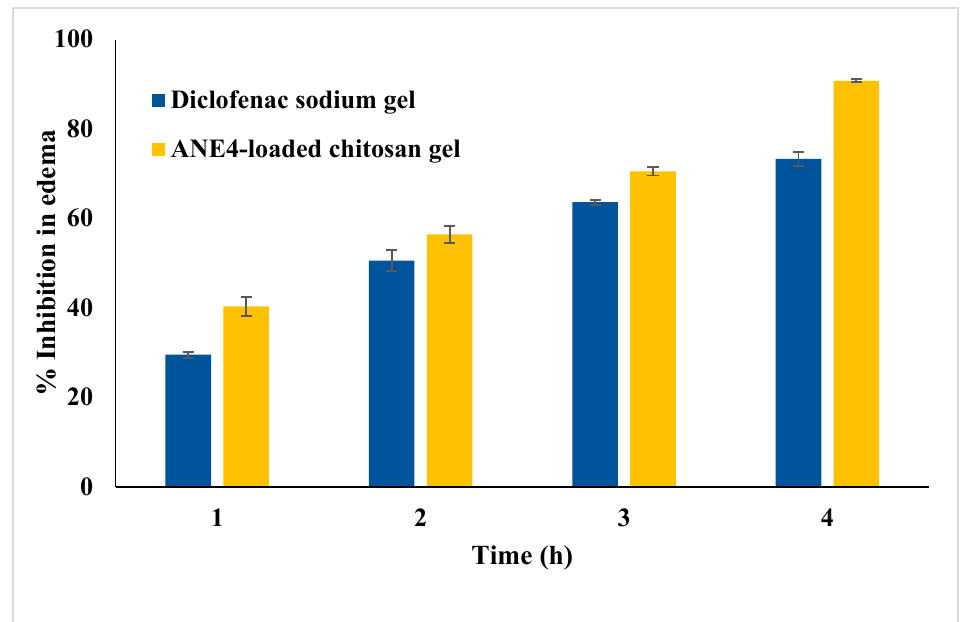
Figure 7. Comparative anti ‐ inflammatory activity of APNE4 ‐ loaded gel and Diclofenac sodium gel.